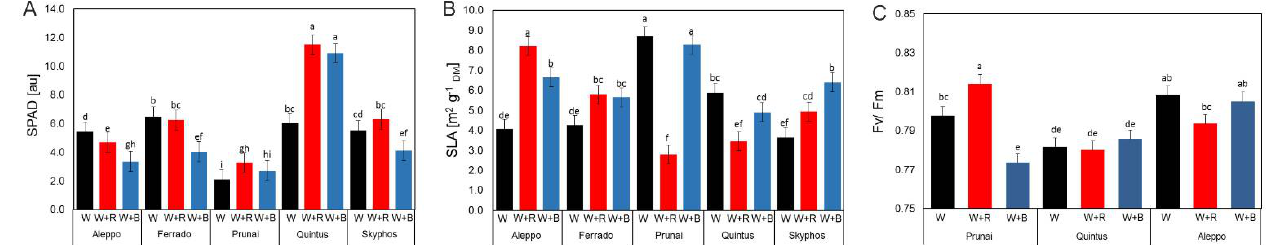
Figure 4. The relative chlorophyll content (SPAD) ( A ); specific leaf area (SLA) ( B ); and chlorophyll fluorescence (Fv/Fm) ( C ) of leaf lettuce grown under different light treatment (W—white light, W + R—white and red light, W + B—white and blue light). Different letters for the same parameter indicate significant differences at the 5% level, according to the Newman–Keuls’s test. The bars represent the standard deviation.